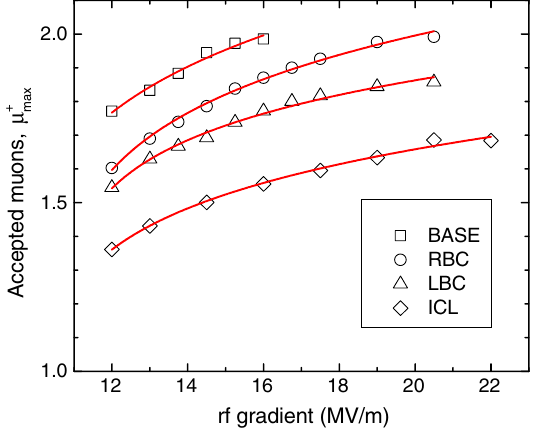
FIG. 11. The degradation of cooling performance with de- creased rf voltage. The vertical axis shows the maximum accepted muon yield within a transverse acceptance of A 30 mm and longitudinal acceptance of A nominal rf gradient for all cooling scenarios is 16 MV =